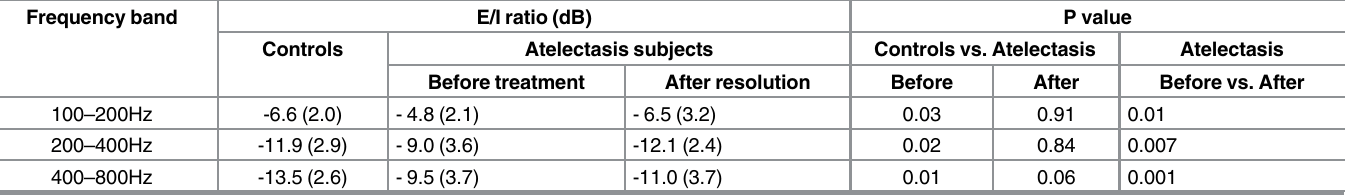
Table 4. Comparison of expiration-to-inspiration ratios (E/I ratios) of breath sound sound pressure for the right middle lobe between controls and atelectatic subjects. Frequency band